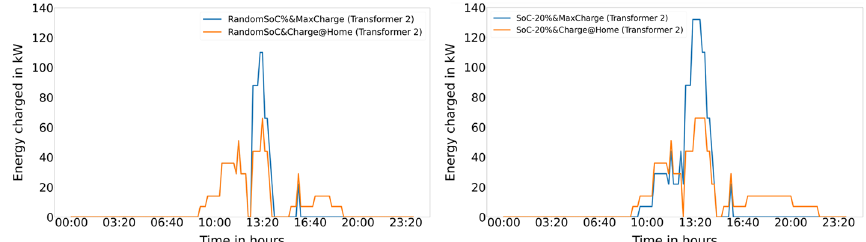
Fig. 15 Power profiles of transformer 2 for the scenario with randomized (left) and 20% (right) SoC, comparing the Charge@Home assumption with the MaxCharge